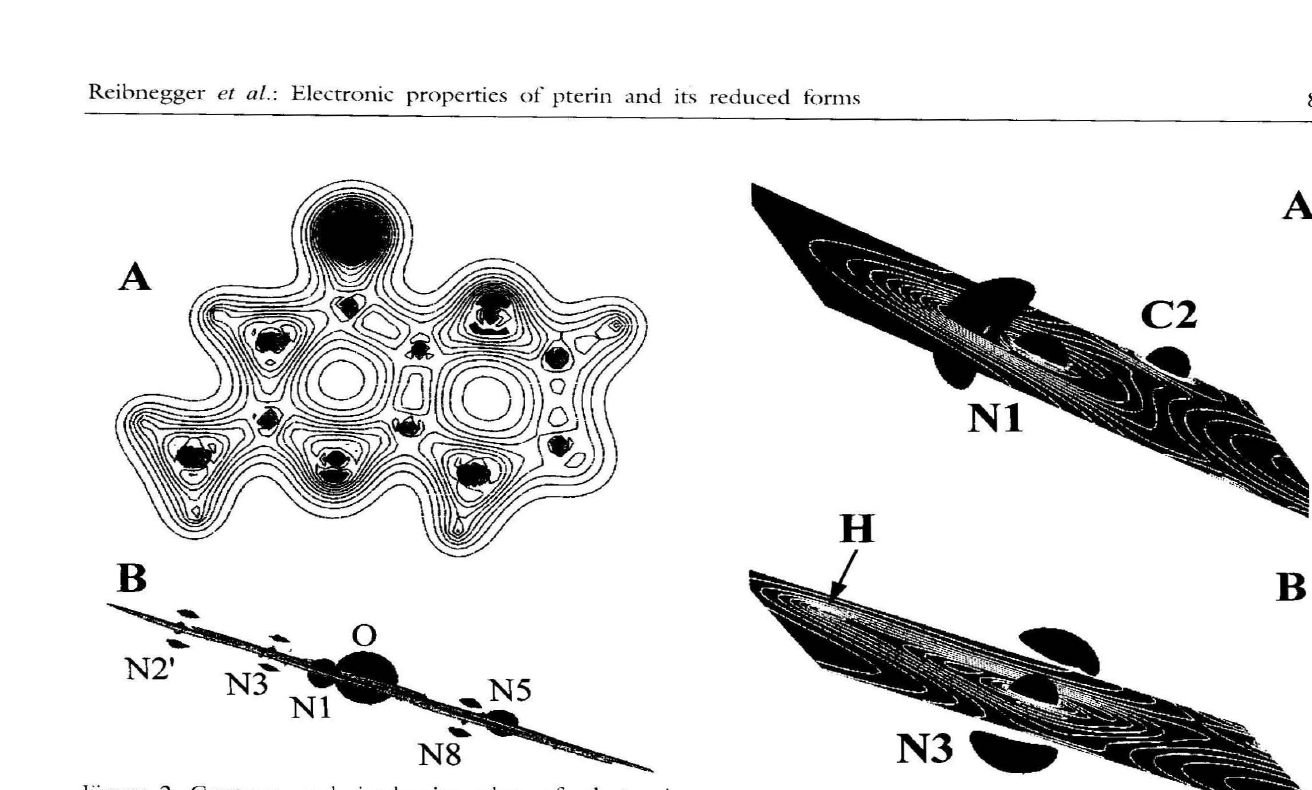
Figure 4. Contour and isodensity plot of electronic charge density of A) nitrogen NI, and B), nitrogen N3 of pterin with higher resolution (for details see Methods). Contour levels are from 0.05 a.u. (outermost isoline) to 0.50 a.u. in steps of 0.05 a.u. Also shown aloe the iso density surfaces at a value of 0.54 a.u. showing spec ifically the differences between the various nitrogen a toms. Note also the inner electron cores of both 111- trogen atoms. In A), the adjacent carbon atom C2 is in cluded in the